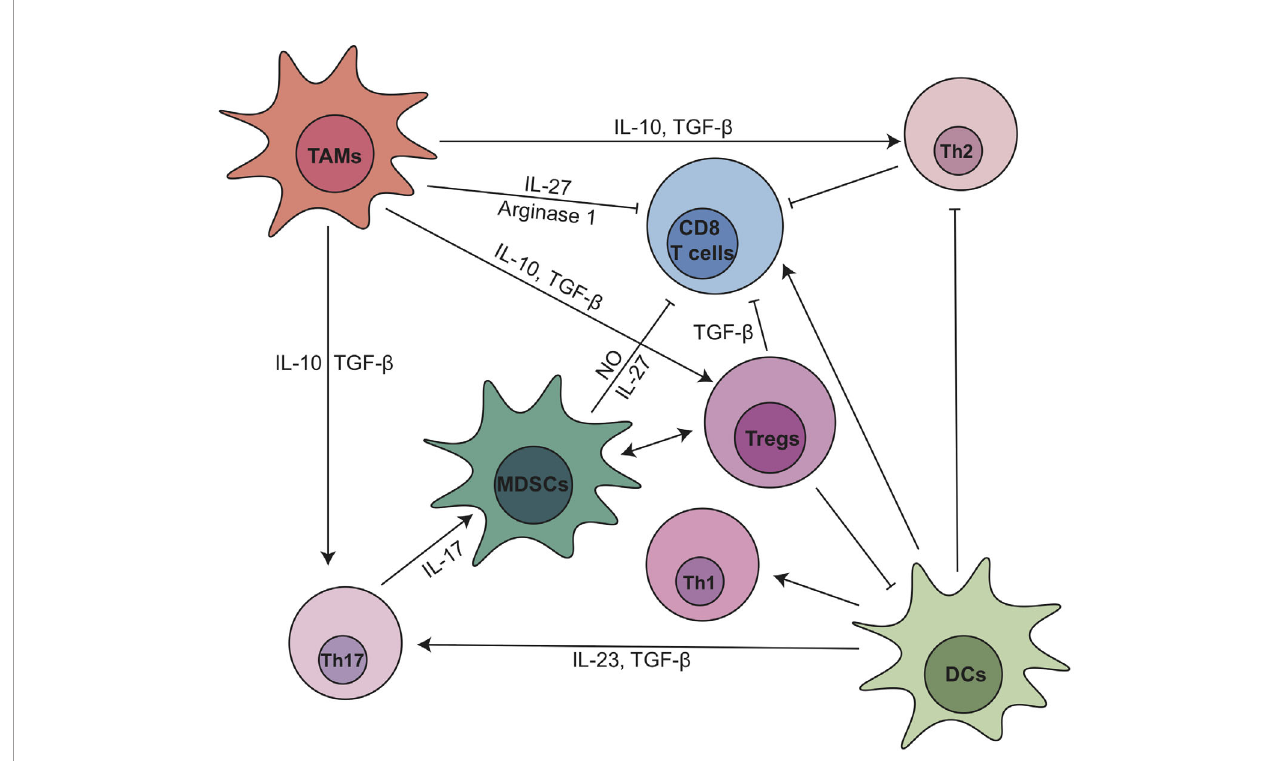
FIGURE 2 | The dynamic cellular and molecular interactionsbetween T cells andmyeloidcellsubsets inpancreaticcancer.DC, dendriticcell;IL,interleukin; MDSCs, myeloid-derivedsuppressorcells; NO, nitric oxide; TAMs, tumorassociated macrophages; TGF- b , transforming growth factor b ; Th,T helper; Tregs, regulatory T